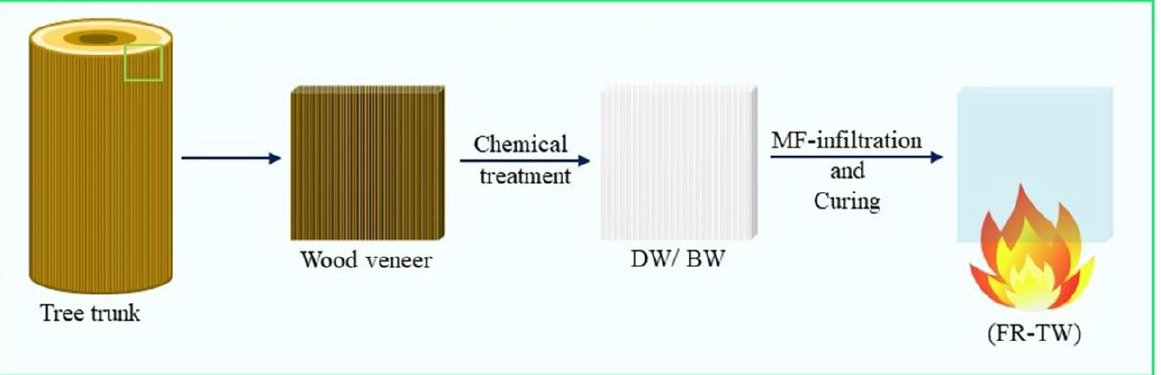
Figure 37. Schematic illustration of fire-retardant transparent wood (FR-TW) fabrication based on melamine formaldehyde, MF. DW is delignified wood where most lignin is removed, and BW is bleached wood where lignin chromophores are modified and a small amount of lignin removed. Reprinted from [50] under CC-BY license.